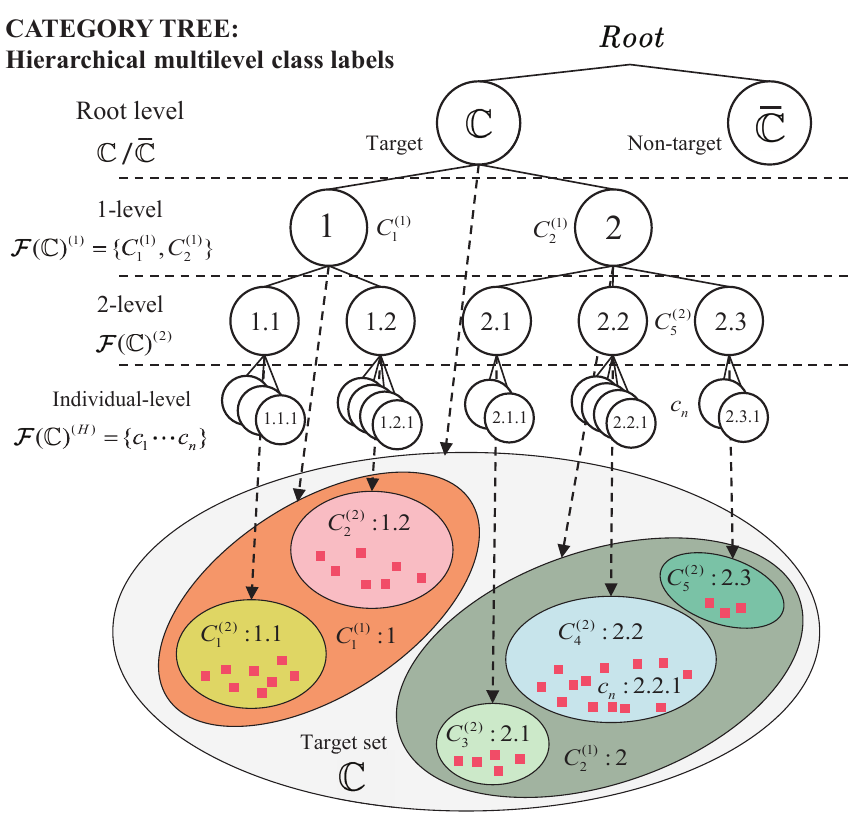
Figure 1. The category